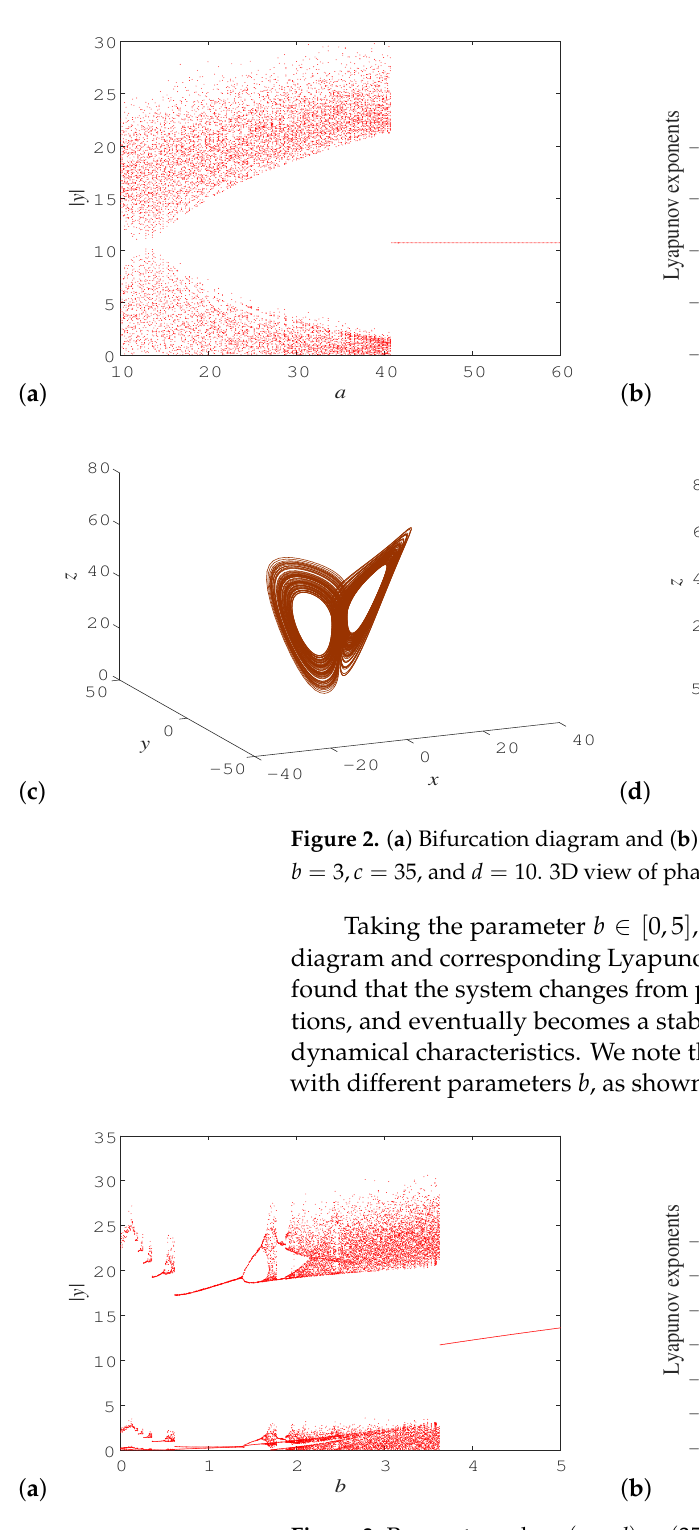
Figure 3. Parameter values ( a , c , d ) = ( 35,35,10 ) , ( a ) bifurcation diagram, and ( b ) Lyapunov expo- nents spectrum of system (2) for b ∈ [ 0,5 ]